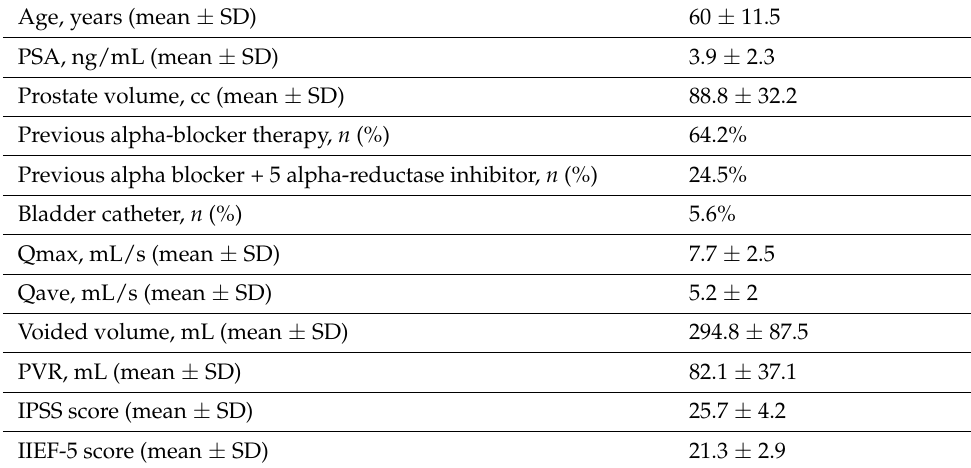
Figure 1. Flowchart reporting patients selected for participation and followed up with. Table 1. Preoperative clinical characteristics. SD, standard deviation; PVR, post-voided residue; IPSS, international prostatic symptom score; IIEF, International Index of Erectile Function.